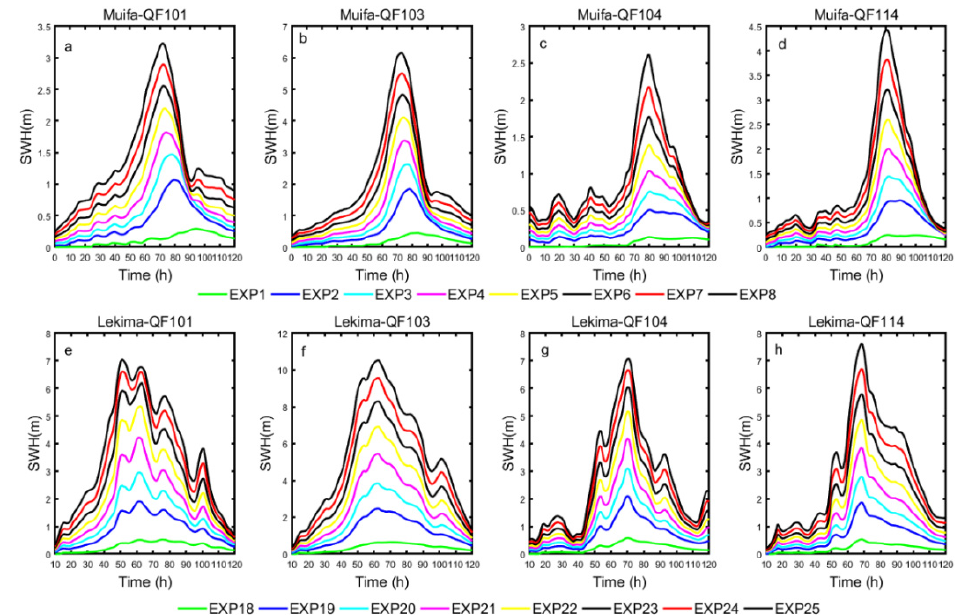
Figure 8 . Significant wave height associated with the maximum wind speed over time at ( a ) QF101, ( b ) QF103, ( c ) QF104, and ( d ) QF114 for Typhoon Muifa and ( e ) QF101, ( f ) QF103, ( g ) QF104, and ( h ) QF114 for Typhoon Lekima.